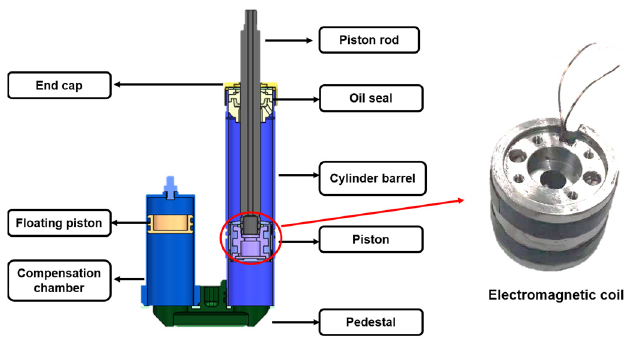
Figure 1. Magnetorheological damper and internal coil structure diagram.